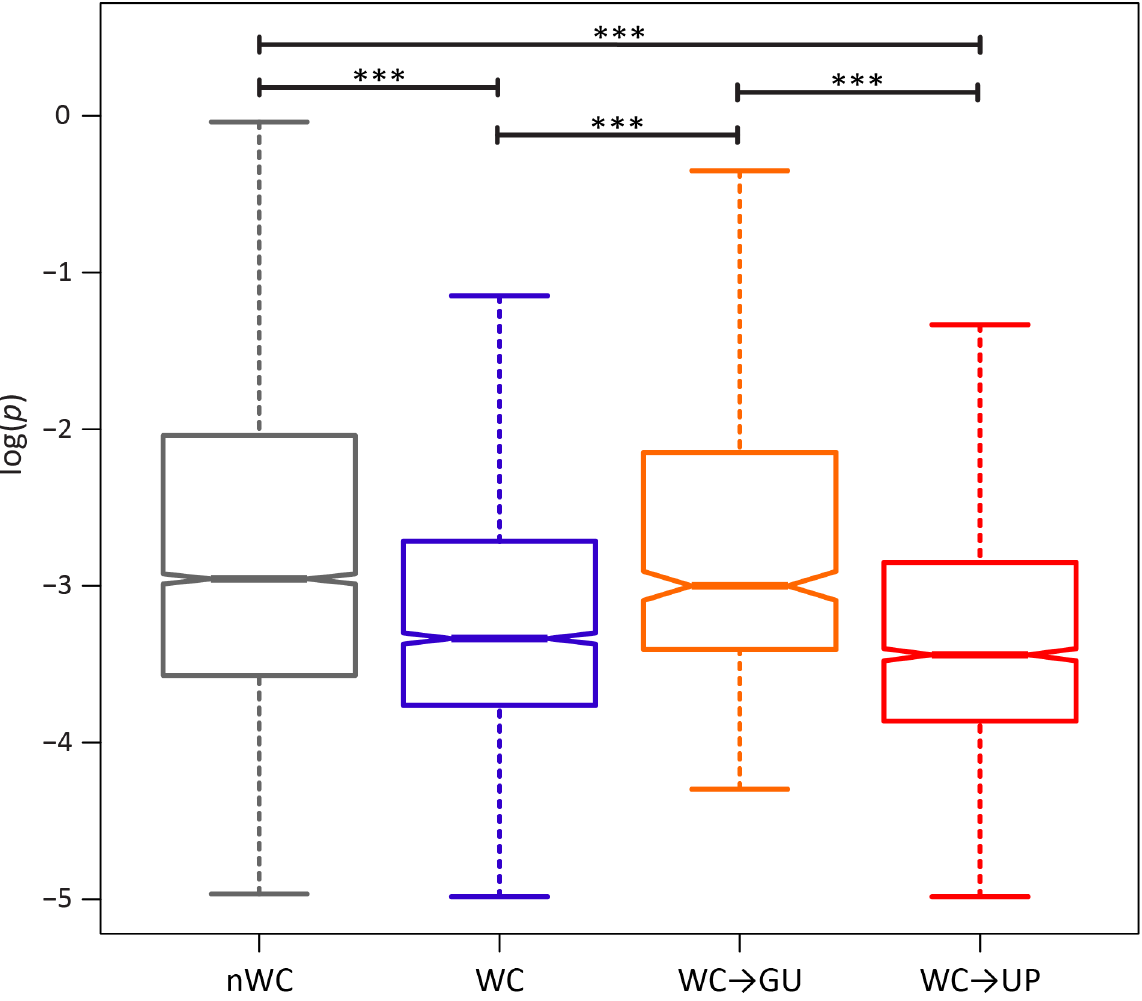
Figure 1. Intra-population frequencies of nWC and single-site WC replacement polymorphisms in the HIV-1 genome. Frequencies are normalized to enable comparisons among classes (see Materials and Methods for details) and plotted on a log 10 -scale. Asterisks indicate p , 0.05 (*), p , 0.01 (**), and p , 0.001 (***).